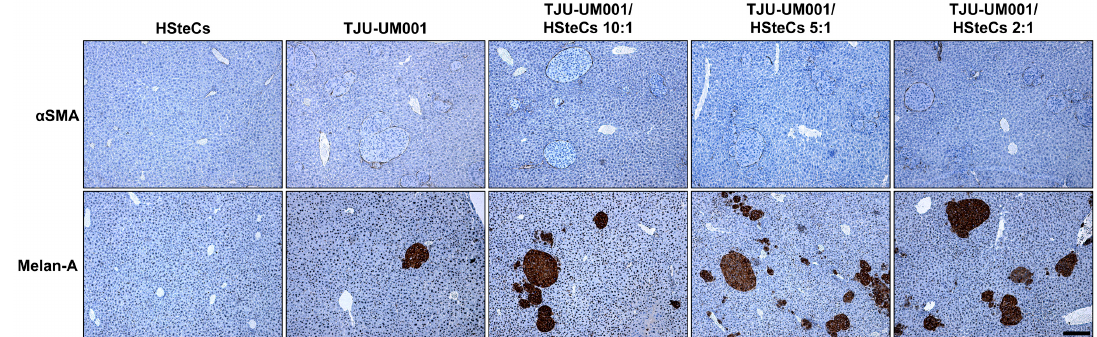
Figure 4. HSteCs are recruited early by metastatic UM cells. Immunohistological analyses of UM-derived liver metastases in triple-immunodeficient mice ( N = 4 per condition) inoculated with the TJU-UM001 cell line alone or in combination with human HSteCs (ratios 10:1, 5:1 or 2:1). The α SMA antibody labels activated stellate cells recruited in the vicinity of UM cells, while the Melan-A antibody highlights UM malignant lesions; the positive signal appears in brown. Scale bar, 100 µm.